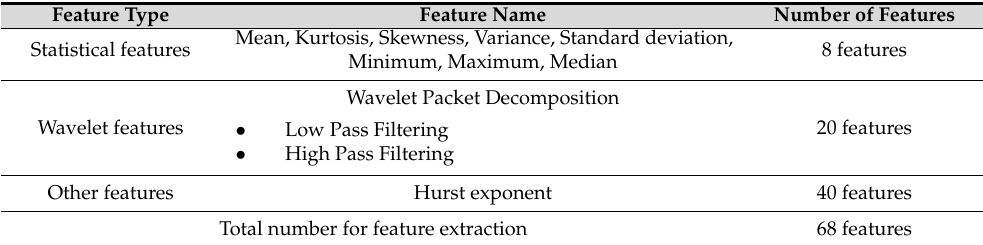
Table 2. Features extracted from EEG signals.